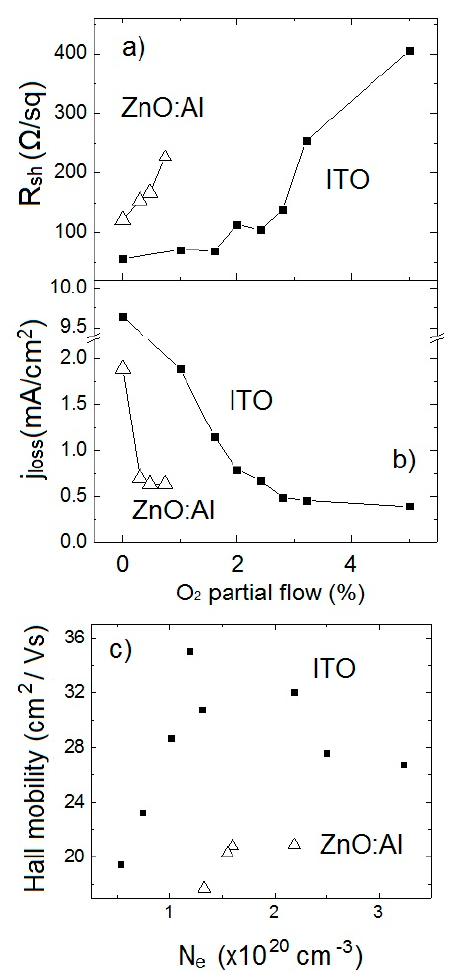
Figure 2. ( a ) Sheet resistance and ( b ) j loss due to absorption in the 300–1200 nm range of the ZnO:Al (open triangles) and indium tin oxide (ITO) (filled squares) single layers on glass deposited under different O 2 concentrations. ( c ) Hall mobility as a function of charge carrier concentration. Note the axis breaks in panel ( b ).